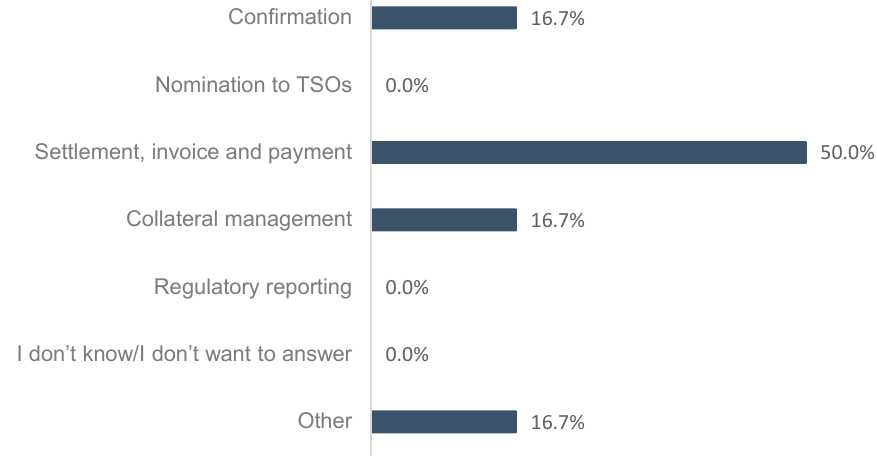
Figure 16. Most benefited post-trade process.